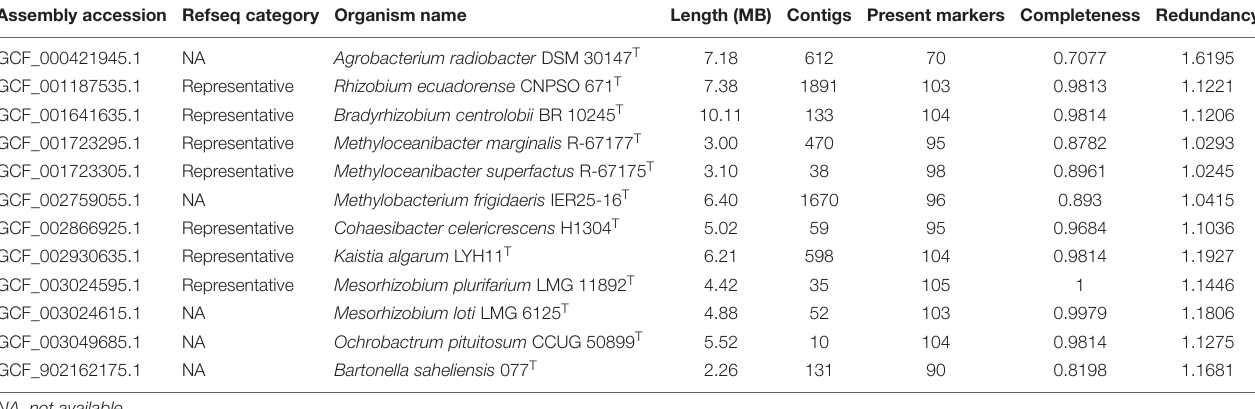
TABLE 1 | Genomes detected with high contamination and/or low completeness.